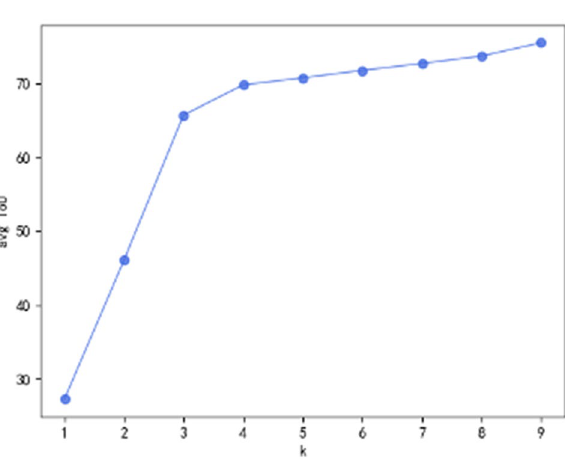
Figure 4. ( a ) Original fusion structure in YOLOv4 and ( b )Modified fusion network in SO-YOLO.